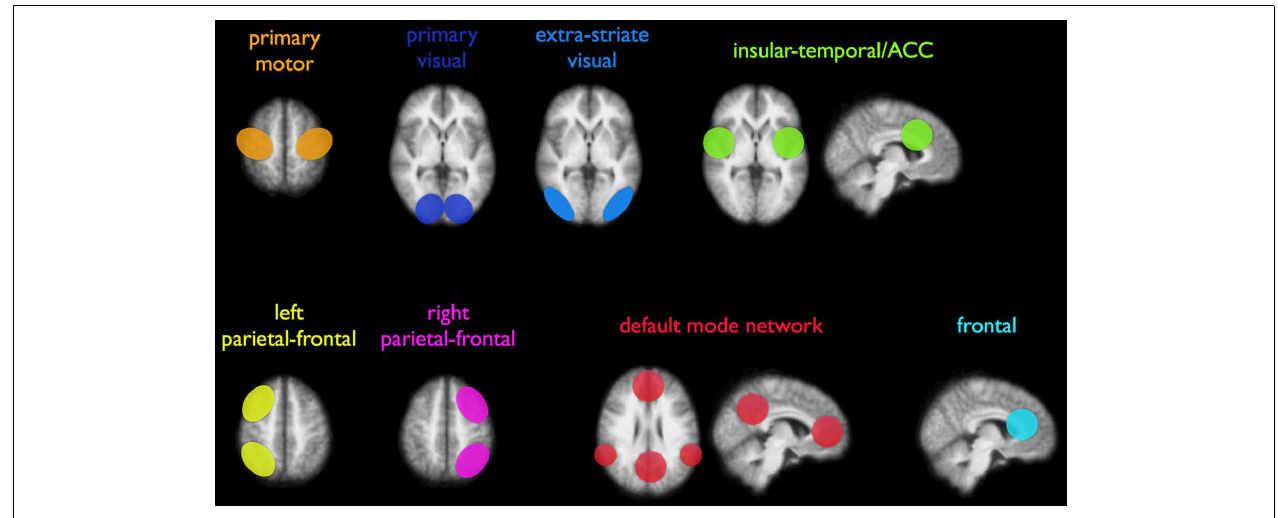
FIGURE 2 | Illustration of eight commonly reported resting-state networks (RSNs), consisting of distant areas that show functional coupling. Both unilateral and bilateral connectivity